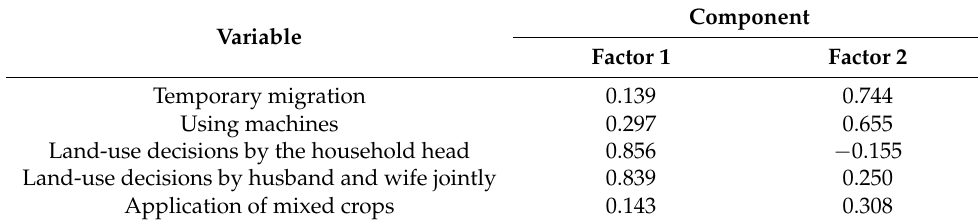
Table 7. Factor loadings on HSoL.